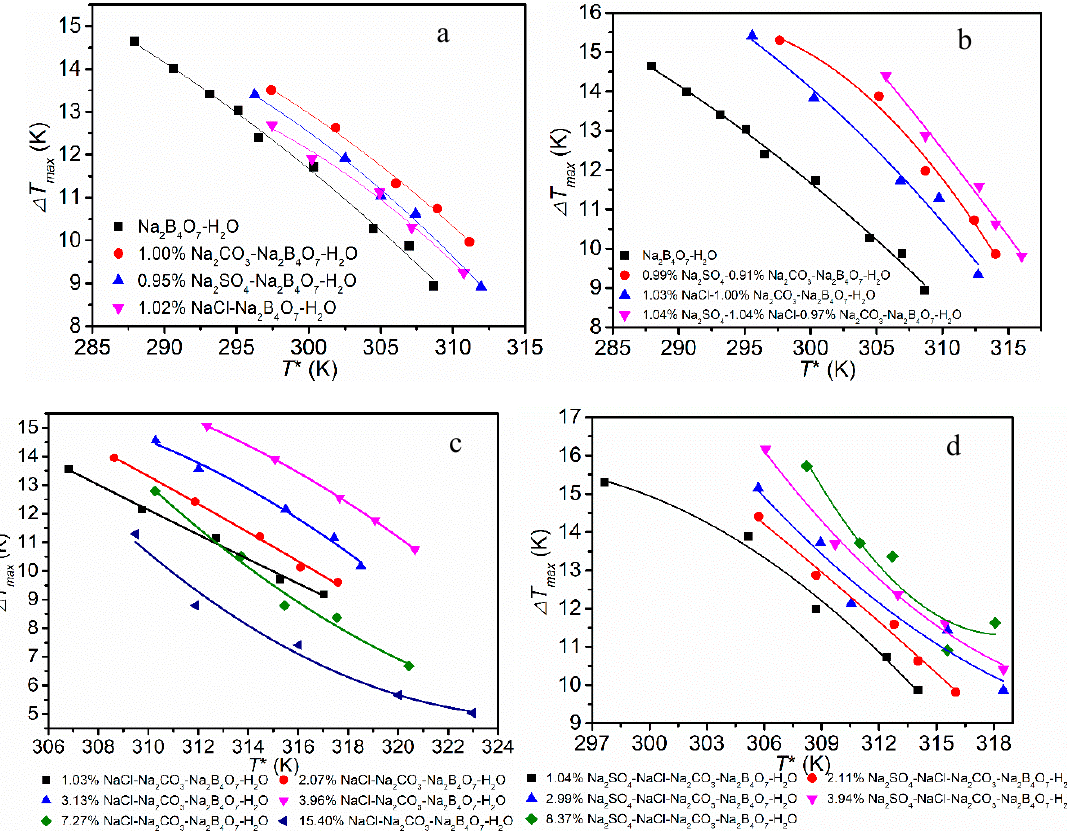
Figure 4. Changes in metastable zone width (MSZW) in different solutions ( R = 55 K/h). ( a ) single salt system; ( b ) double salt system; ( c ) NaCl-Na 2 CO 3 -Na 2 B 4 O 7 -H 2 O systems; ( d ) Na 2 SO 4 -NaCl-Na 2 CO 3 -Na 2 B 4 O 7 -H 2 O systems.